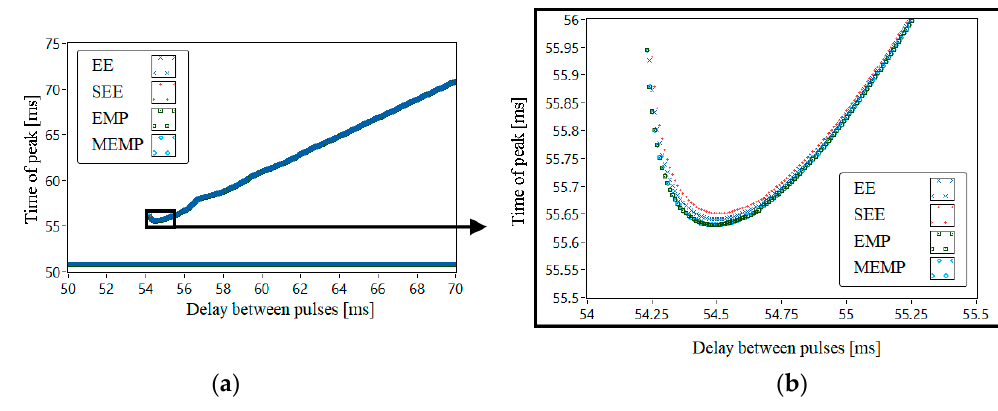
Figure 6. Input and output signals generated during refractory analysis of system (1).